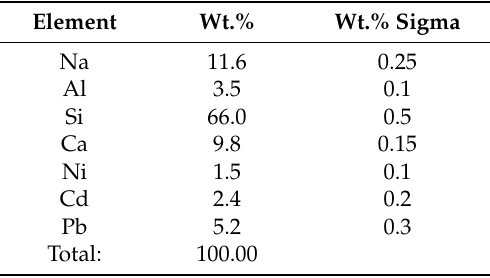
Figure 8. ( A ) Column test carried out in ternary solution (0.5–1 mm RWPG particle size, 10 g RWPG, 0.2 Lh − 1 , 5 mg Me +2 L − 1 , pH = 6, and T = 298 K). ( B ) SEM image of a RWPG bead after the sorption process.